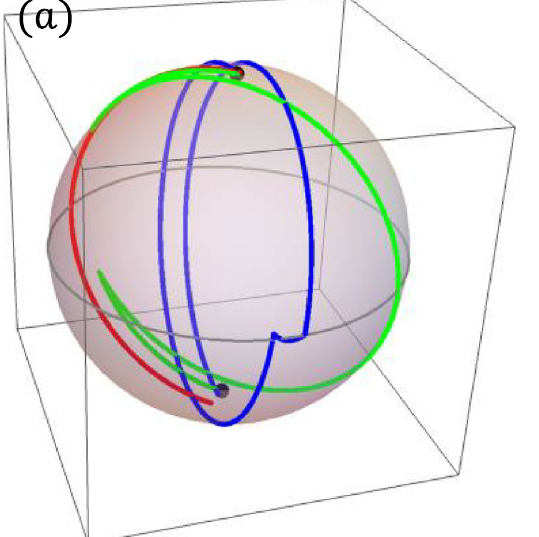
Figure 4. The performance of the ORE robust CPs. In ( a ), the trajectories with ORE for two CPs targeting the (π) 0 operation are drawn. The red, green, and blue lines represent the elementary π operation, CORPSE, and 0.1 . The initial state is z . In ( b ), we plot the accuracy of CORP 2 SE, respectively. The ORE rate is set to be f = (cid:31) these operations defined by the great-circular distance as a function of the ORE rate f . The colours of the curves represent the same operations as those in ( a